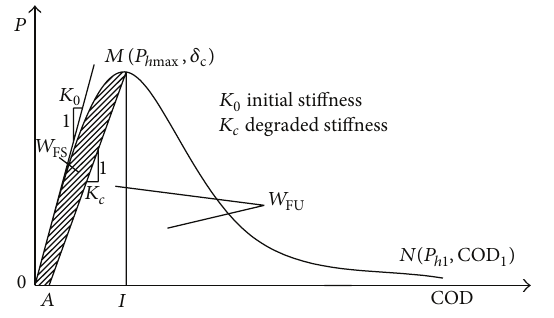
Figure 1: Energy consumption for an entire crack propagation